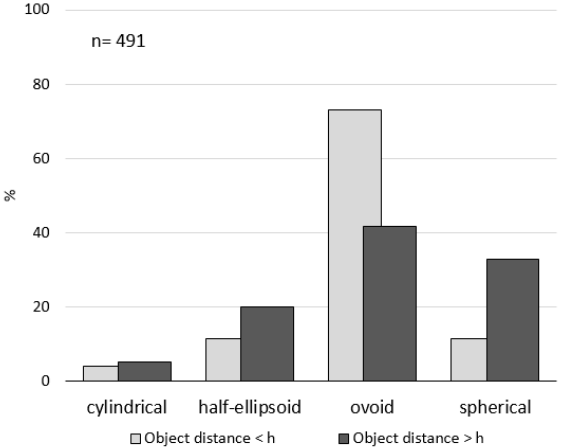
Figure 7. Percentage distribution of crown shapes of all trees for two distance classes of the closest object. For the different tree species and their relationships to crown shape, we recognize for R. pseudoacacia a seven times higher probability of observing cylindrical crowns than for the reference species A. platanoides. All other species show lower probabilities.